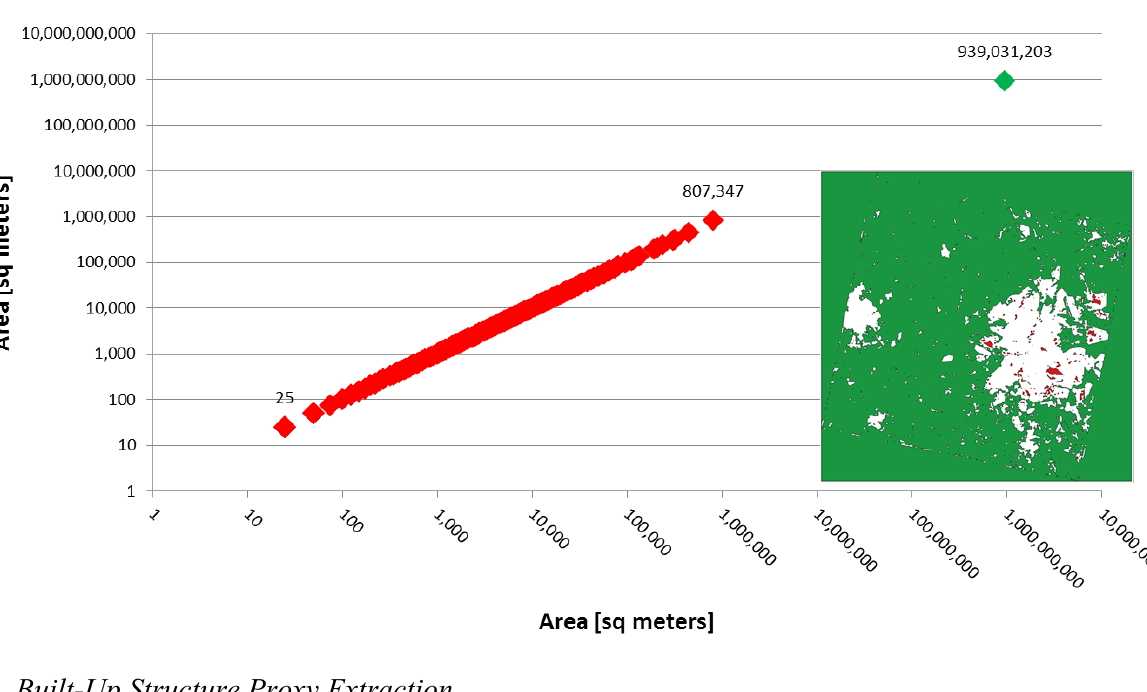
Figure 2. Distribution of area values for non-built-up areas (in square meters) for the figure on the right (white = urban area, red = ―holes‖, green = natural background). Note the log scale on both